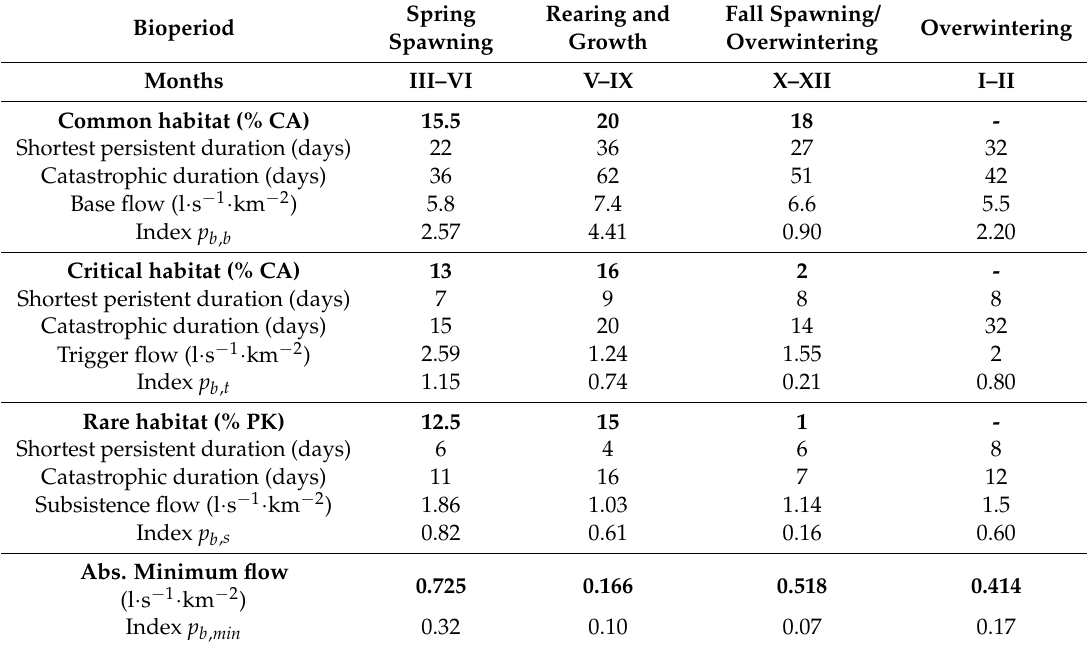
Spring Rearing and Fall Spawning/ Spawning Growth Overwintering